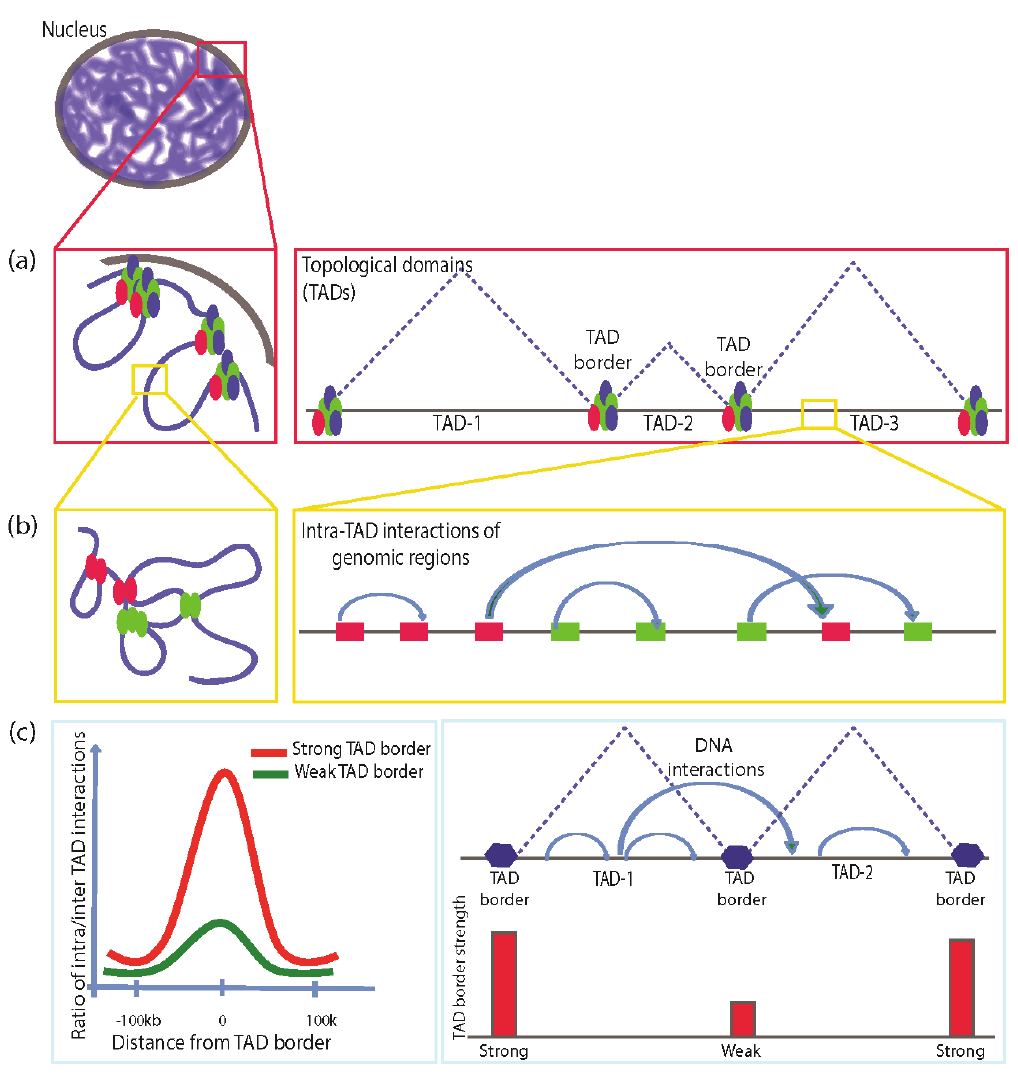
Figure 1. Chromatin nuclear organization with perspective of TAD structuring. ( a ) Megabase-scale chromatin looping and associated topological domain structuring. Insulator factors (shown in colored ovals) are decorated over chromatin mediating the Mb level chromatin looping; ( b ) Kilobase-scale chromatin looping mediated by insulator factors and associated co-factors facilitates specific interactions of gene regulatory regions. Kb-scale looping defines the transcriptional network on the genome; ( c ) TAD border strength and the DNA interaction frequency. A stronger TAD border is defined by the lesser frequency of inter-TAD